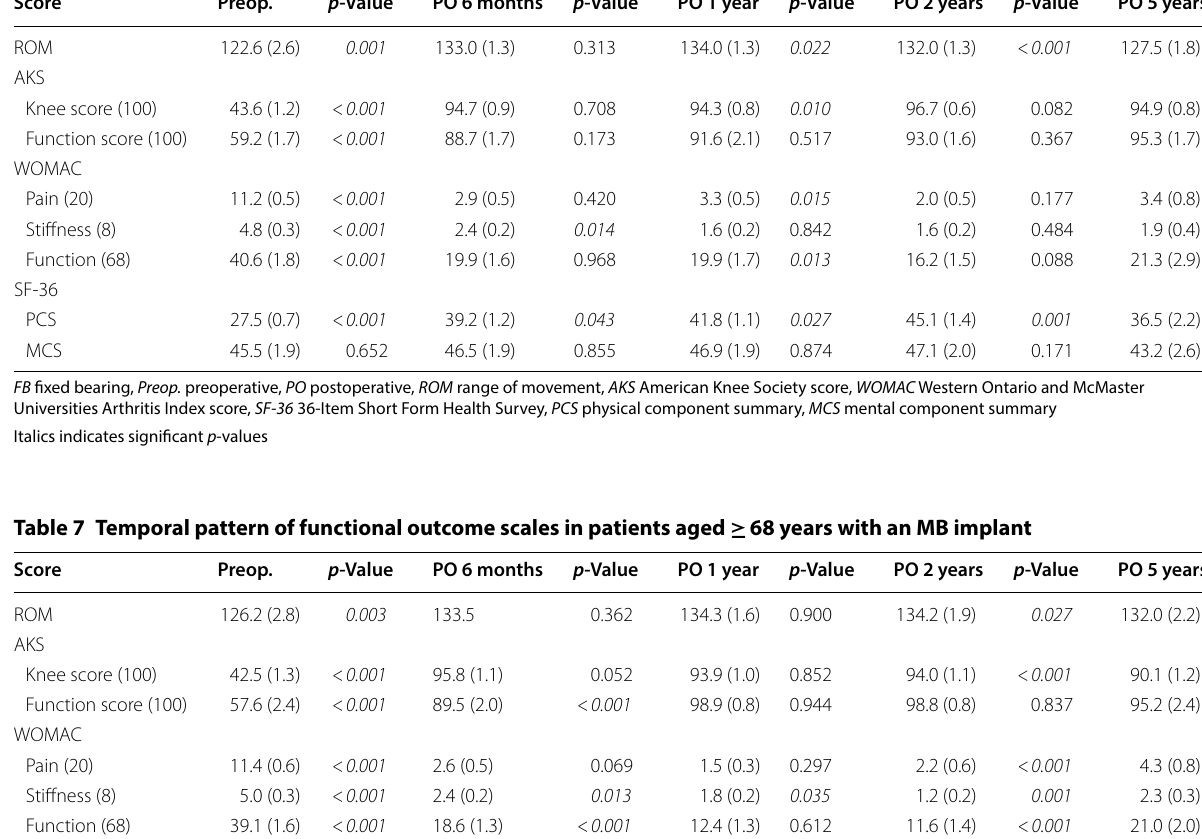
68 years with an FB implant ≥